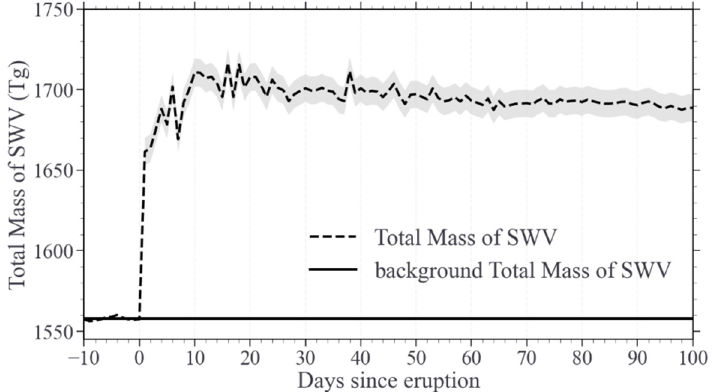
Figure 4. Time series of the total mass of stratospheric water vapor (SWV, 1 Tg = 10 12 g) before and after the Tonga eruption (15 January 2022). The shaded region shows the standard deviation of the total mass of stratospheric water vapor during 100 days after the eruption. The solid line is shown for the total mass of SWV averaged 0–10 days prior to the eruption of Tonga, which is set as a background value.